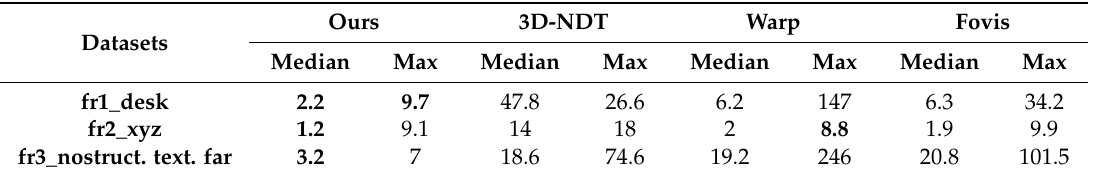
Table 1. Comparison of median (maximum) absolute trajectory error in mm for joint optimization on RGB-D sequences of the Freiburg Benchmark Dataset, best results in bold.